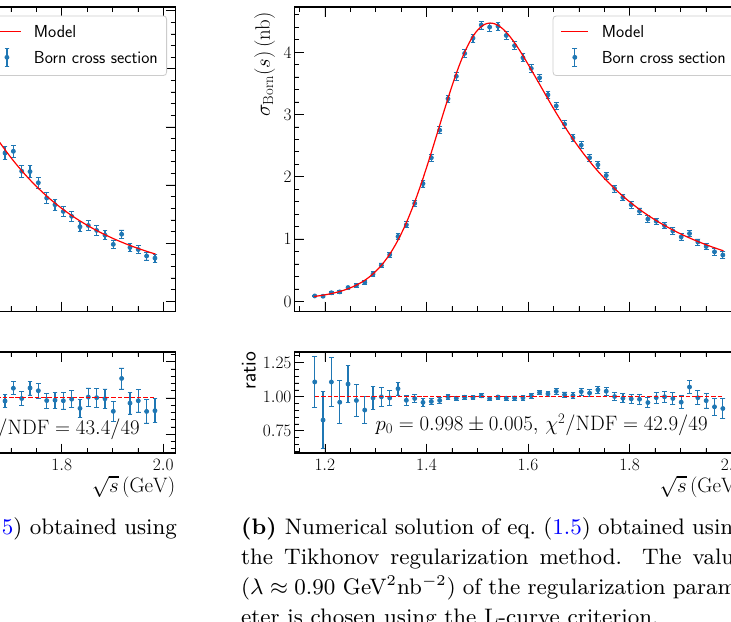
Figure 12. Comparison of the e + e − → ηπ + π − model Born cross and the numerical solution of eq. (1.5). Values of the parameter σ E at each c.m. energy point are same and equal to 2